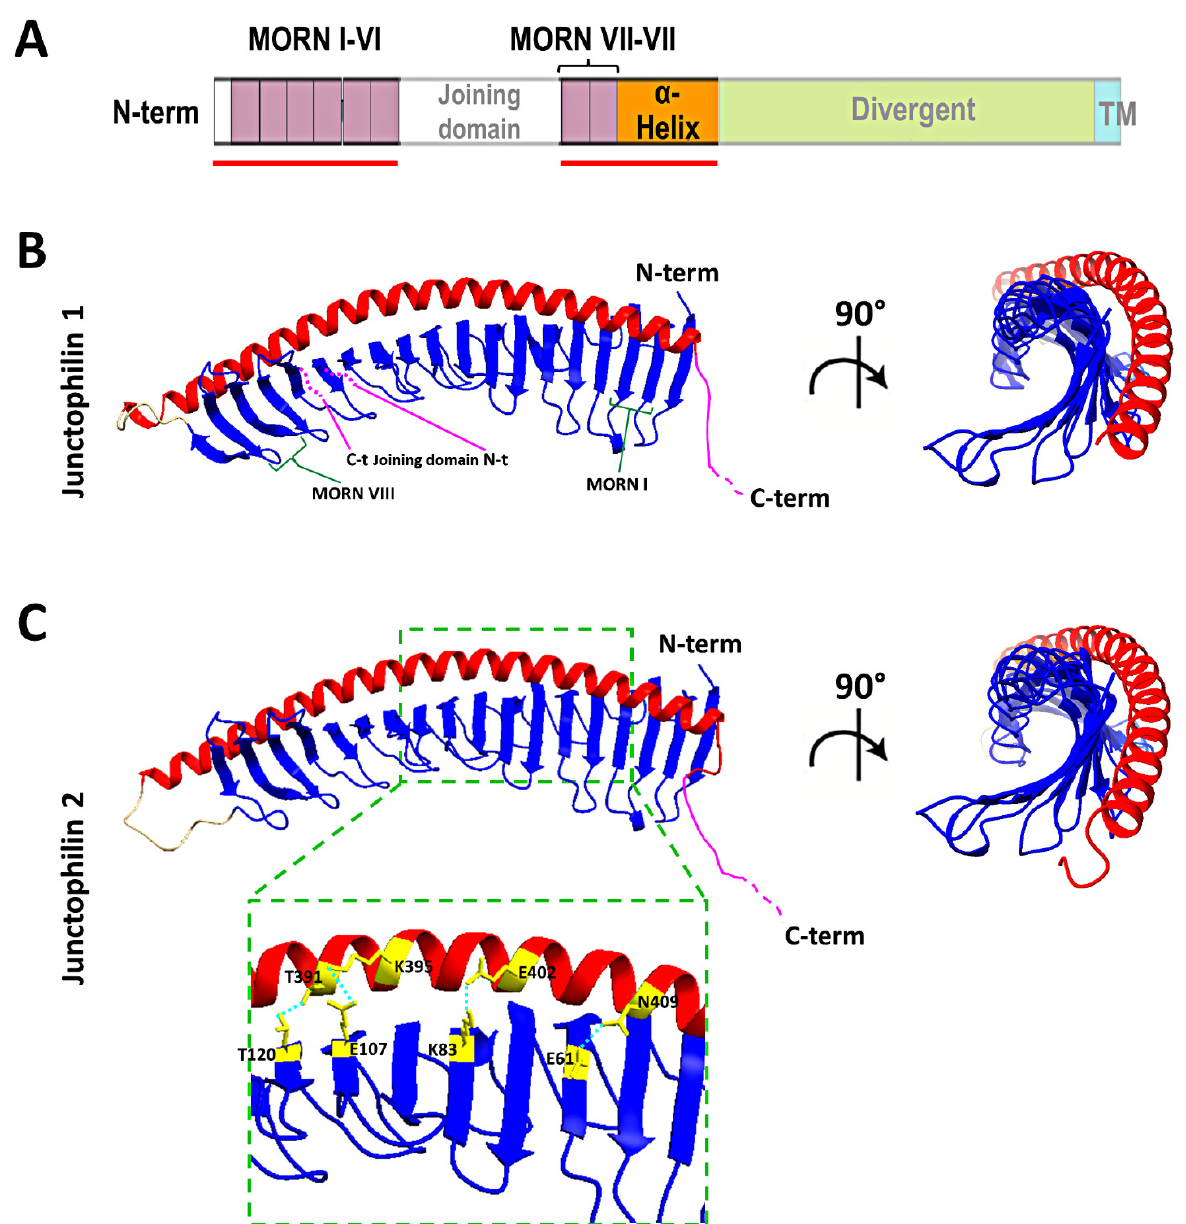
Figure 3. Structure of the MORNs and α -helical domains of human junctophilin1 and junctophilin2. ( A ) Schematic representation of junctophilin domain as shown in Figure 2; the solid red lines indicate the regions for which the structure is predicted with high fidelity by Alphafold2 and illustrated in ( B , C ). ( B , C ) predicted structures of the MORNs- α -helical domains of junctophilin1 ( B ) and junc- tophilin2 ( C ). The α -helical domain (in red) lies on the convex side of the MORN domains half-pipe structure (in blue) in both junctophilin1 and junctophilin2. β -sheet hairpins forming MORN domains I and VIII (green parentheses) and the position of the N-terminal end (N-t) and C-terminal end (C-t) of the joining domain (in pink), which is absent in this representation, are indicated in ( B ). The inset in ( C ) shows some of the residues that form the hydrogen bonds that stabilize the association between the MORN domains and the α -helical domain of junctophilin2.